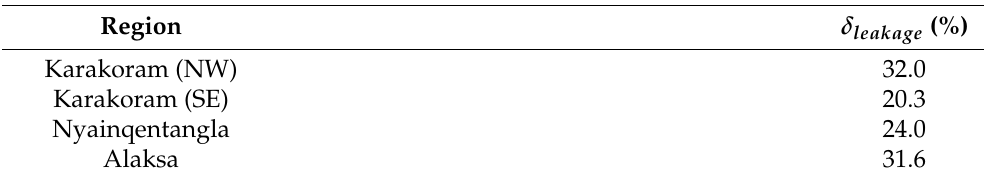
Table 1. The leakage error for each of the mascon configurations, expressed as mean percent error as in Equation